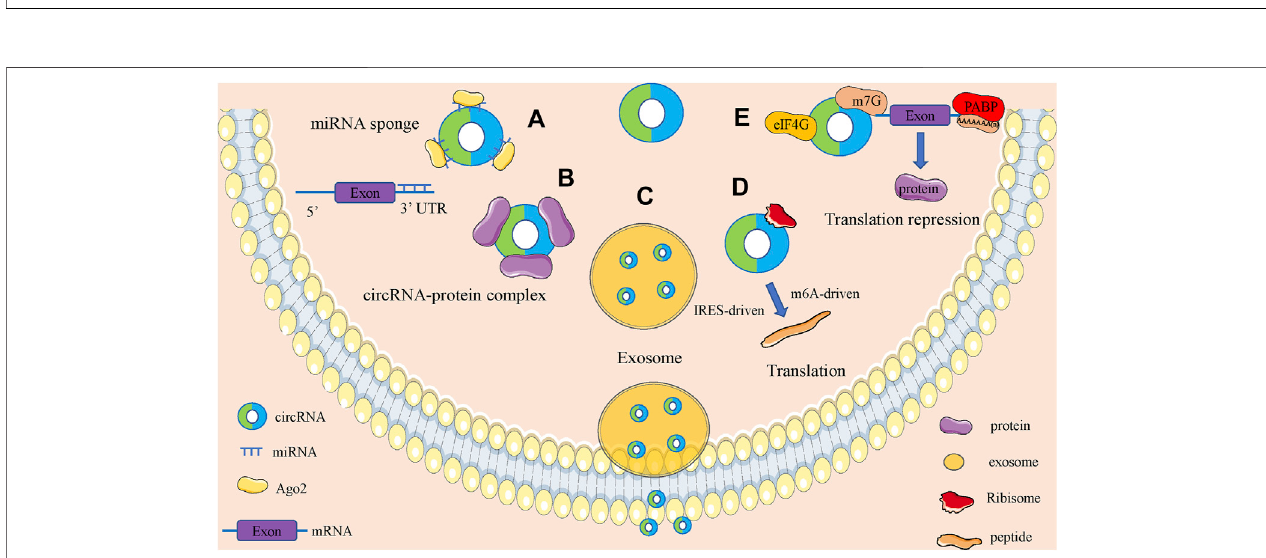
FIGURE2| BiologicalfunctionofcircRNAs. (A) .CircRNAscanactasmiRNAspongestoregulatetheexpressionofdownstreamgenes. (B) .CircRNAscanbindto RNA binding protein and regulate parental gene expression. (C) . Some circRNAs can be carried by exosomes and involved in the process of cell-cell communication. (D) . CircRNAs can encode proteins based on IRES-driven and m6A-driven models. (E) . CircRNAs can bind with proteins to establish circRNA-protein complexes and alter the functions of some proteins.